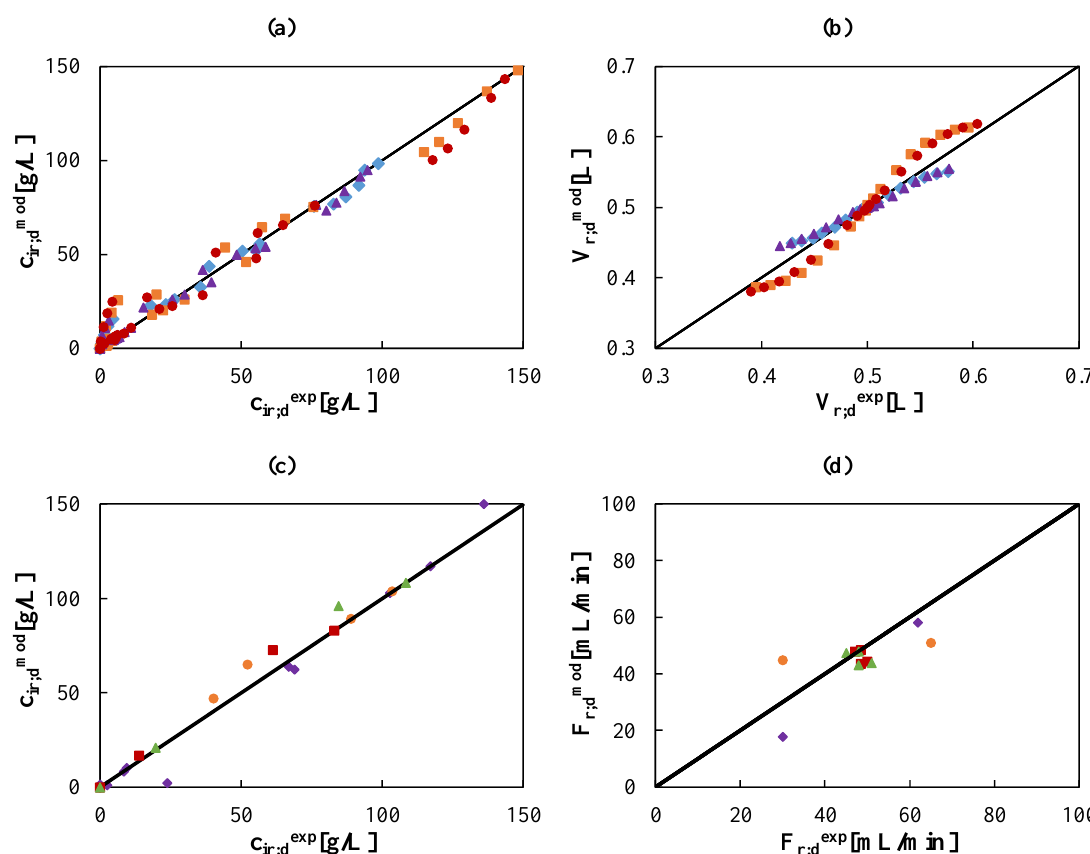
Figure 8. Parity plots of all experimental (exp) and predicted (mod) values. ( a )&( b ) species concentration and tanks volumes in retentate and diffusate compartments for tests with initial HCl at 73 g/L (2 mol/L), Zn at 5 ( ♦ , ) and 10 ( , ) g/L, and Fe at 100 ( ♦ , ) and 150 ( , ) g/L. ( c )&( d ) species concentration and flow rates in retentate and diffusate streams for tests 1 ( ) 2 ( ), 3 ( ), and 4 ( ♦ ) named in Table 2.